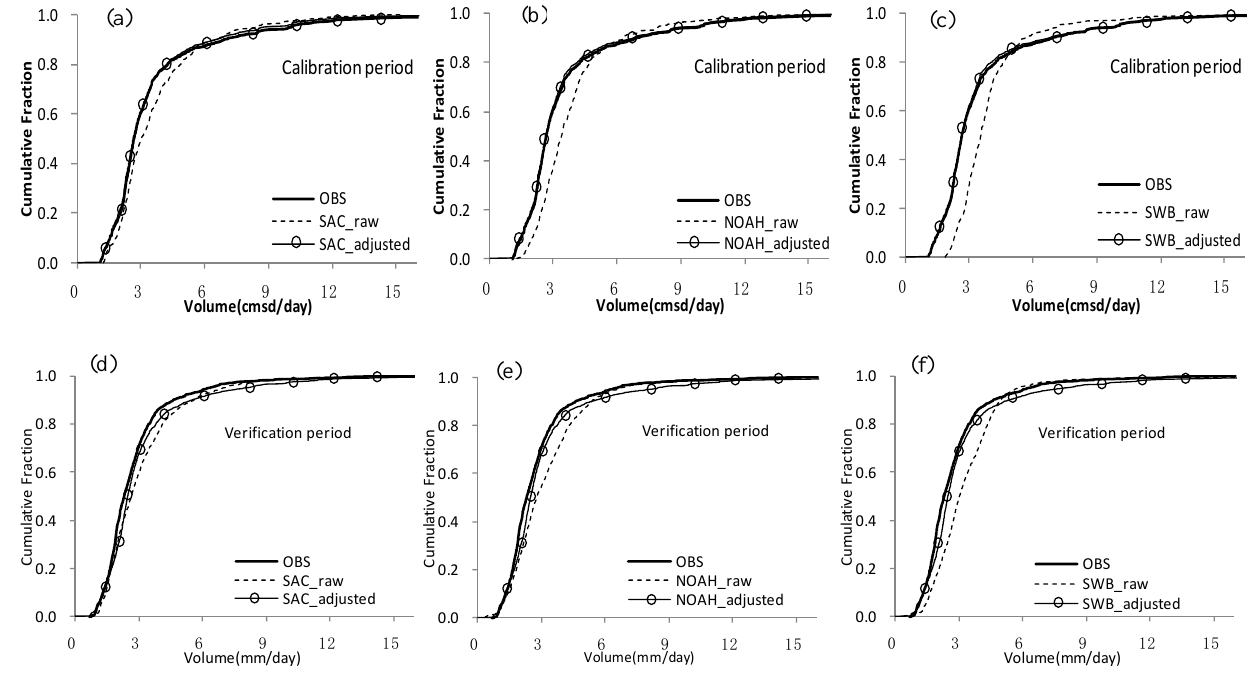
Fig. 5. The CDFs of observed ensemble, raw ensemble and GLMPP adjusted ensemble members for the SAC, SWB and NOAH